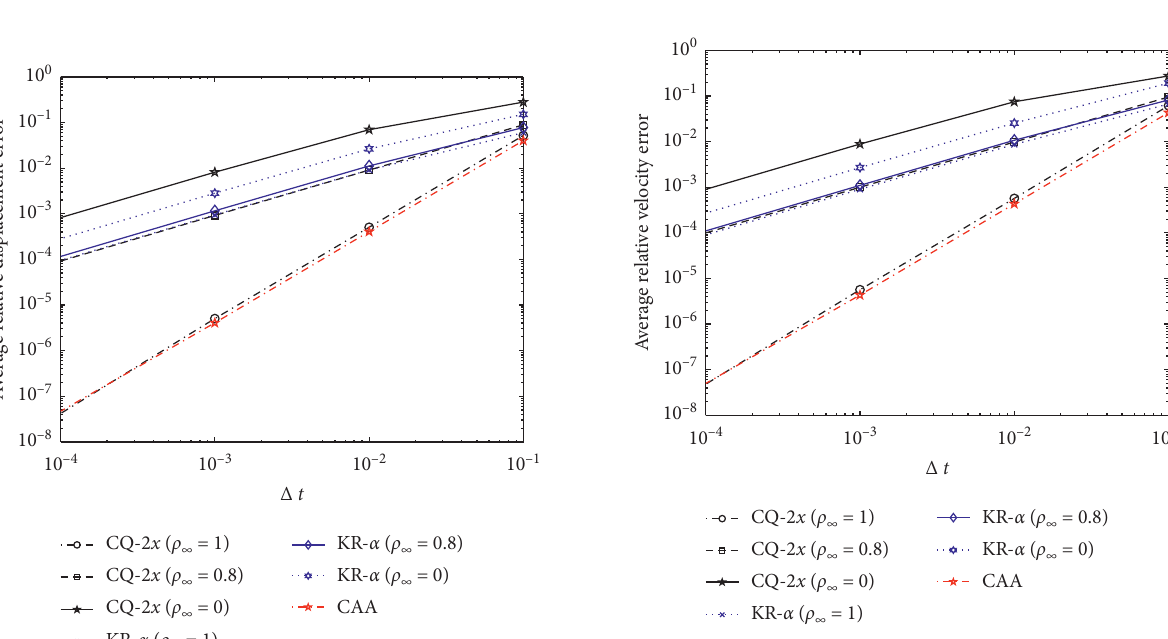
Figure 10: Convergence rate of CQ-2 x assessed in terms of the average relative velocity